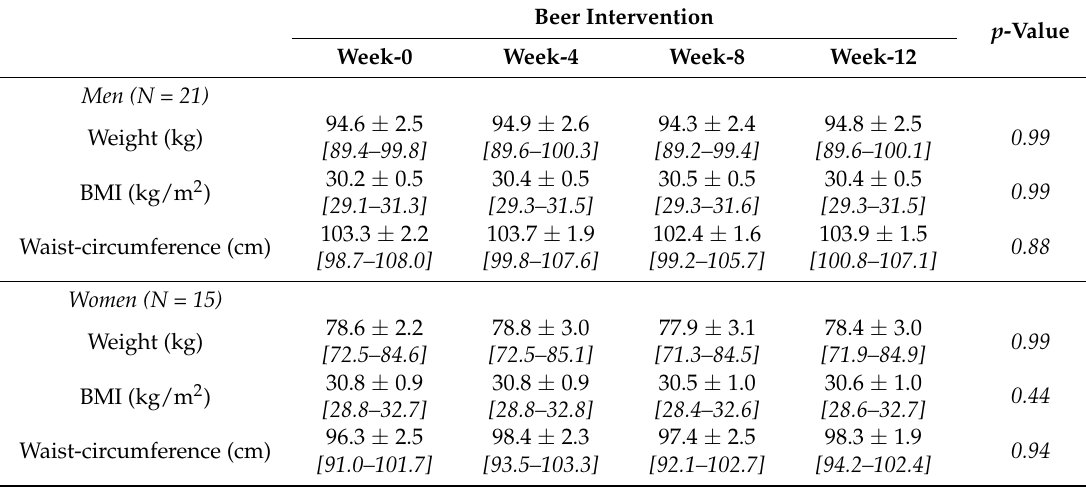
Beer Intervention